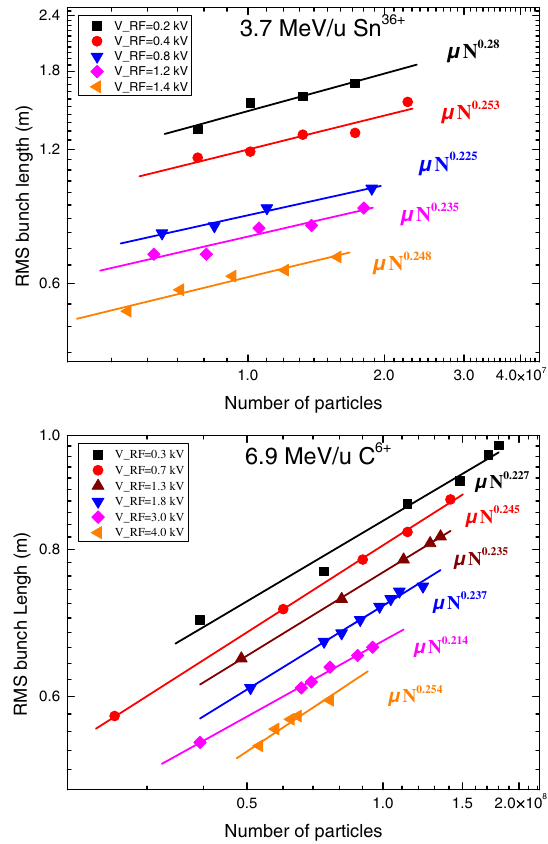
FIG. 5. Dependency of the rms bunch length on the stored particle number for different rf amplitude for 3 . 7 MeV = u 112 Sn 36 þ and 6 . 9 MeV = u 12 C 6 þ ion